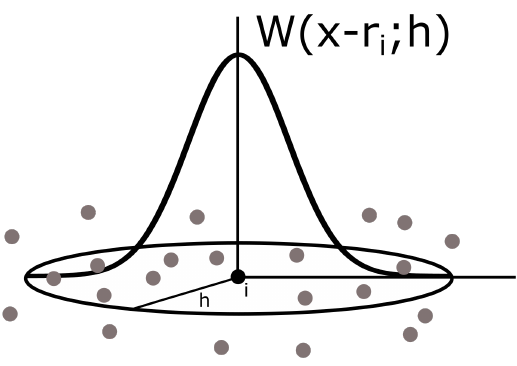
Figure A1. The i -th SPH particle has an overlap with the j -th particle located in the region of | x j − x i | ≤ h